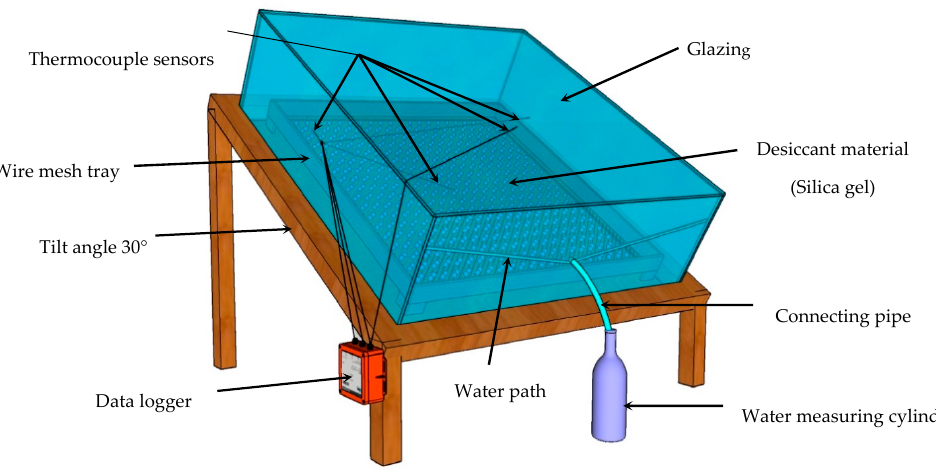
Figure 5. Graphical diagram of the SPAWH.